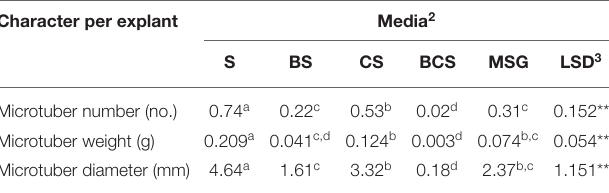
TABLE 2 | Means over clones 1 for various microtuber characters in different